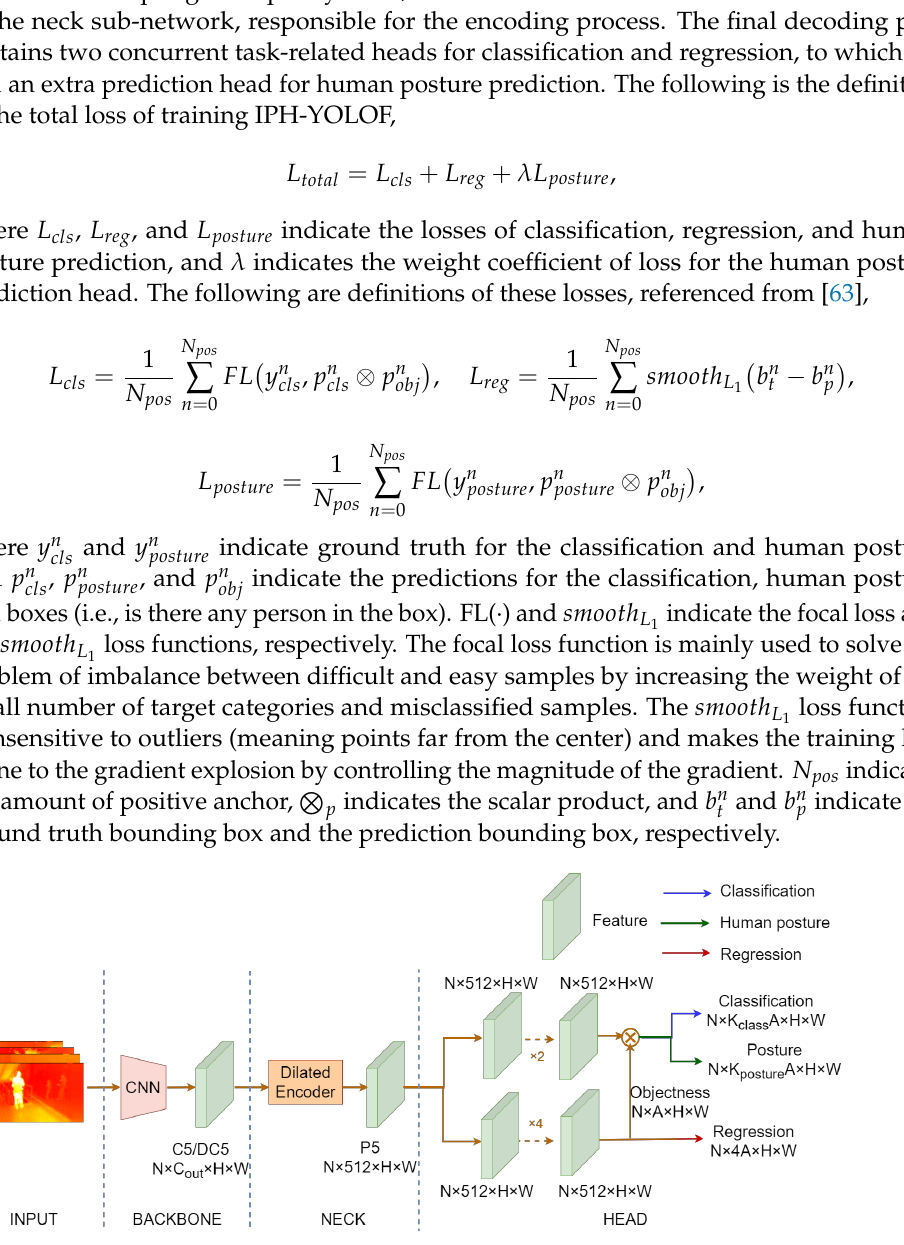
Figure 5. The generalstructure of the IPH-YOLOF detector we proposed. The network structure is a carryover from YOLOF [58] with the difference of an extra head that is utilized to predict human